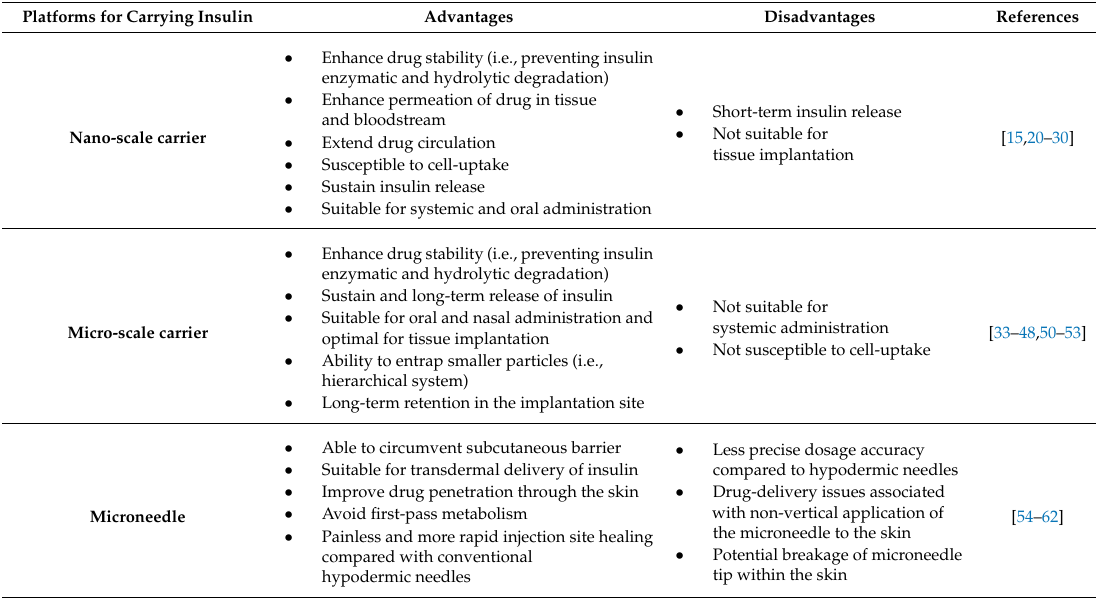
Table 2. Platform for carrying insulin: advantages and